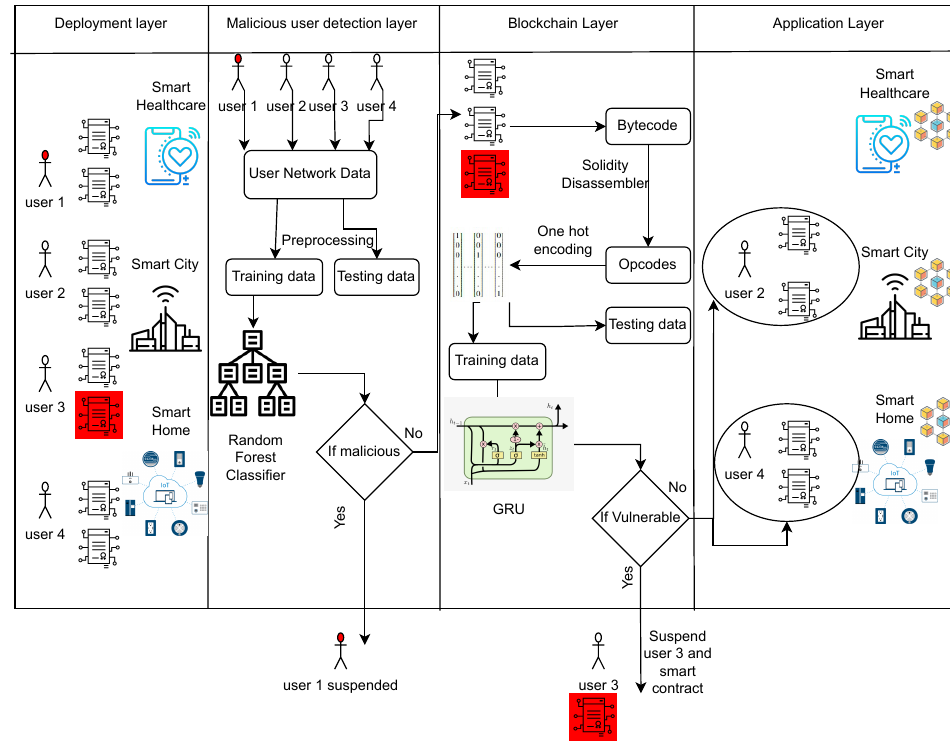
Figure 1. Proposed system